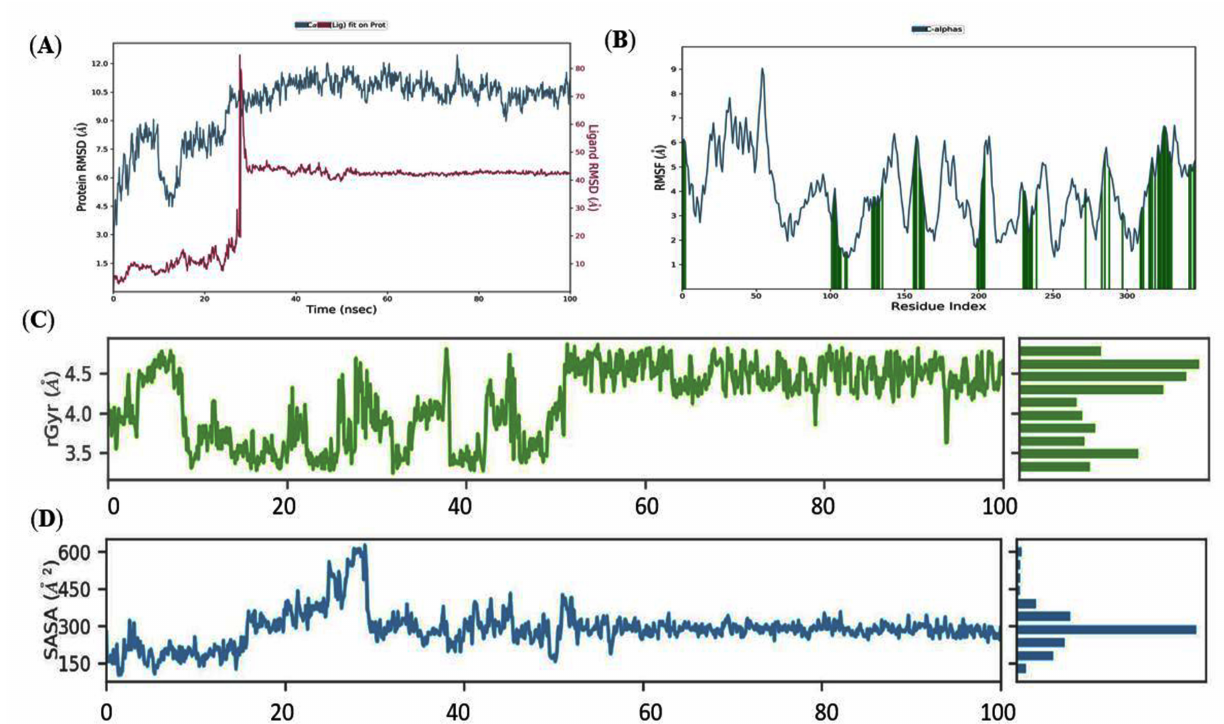
Figure 7. Conformational constancy of ‘Apo’ and ‘Holo’ states of PhcA protein simulation study. ( A ) Backbone-RMSD of PhcA. ( B ) C α -RMSF profile of PhcA. ( C ) Rg profile of PhcA. ( D ) SASA analysis of Apo and Holo states of PhcA protein throughout the simulations.